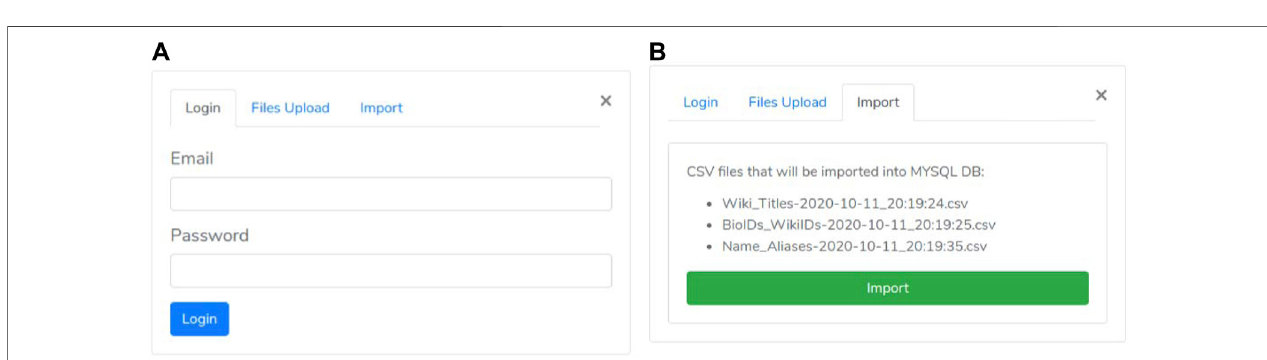
FIGURE3| UploadPanel:Suchapanelallowsamanageruserofthesitetoloadthegraphandmetadata. (A) Fileuploadpanel; (B) Fileuploadpanelwithprogress bar displaing the upload status.